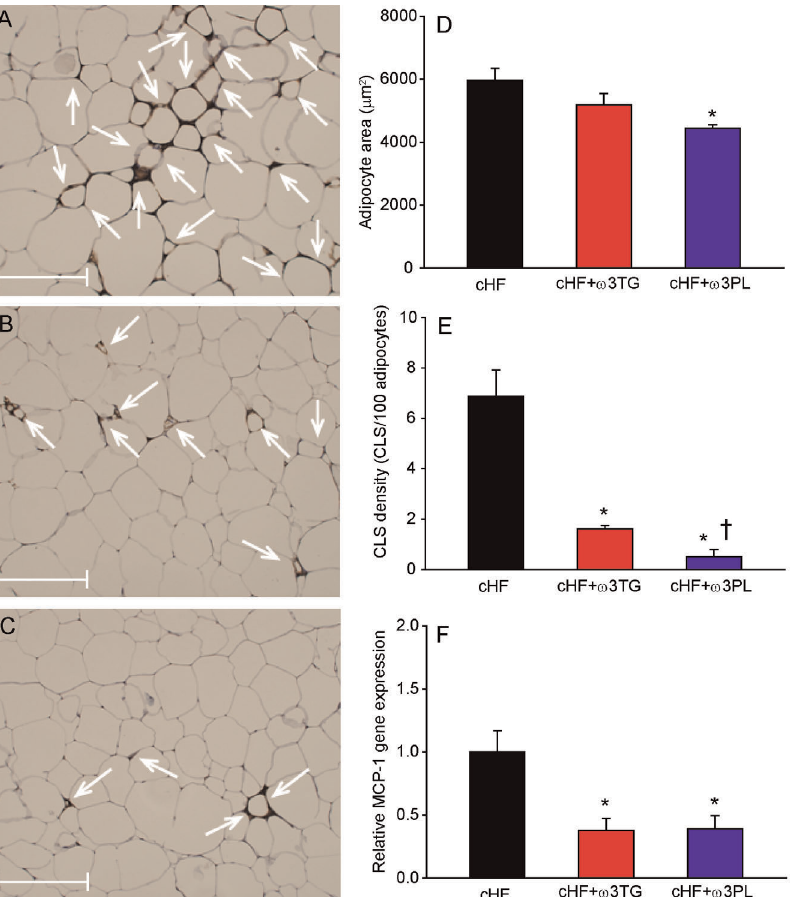
Figure 5. Reversal of adipose tissue hypertrophy and low-grade inflammation by dietary LC n -3 PUFA. Following a 4-month period of cHF-feeding, mice were fed for additional 9 weeks with cHF diet or treated using either cHF + v 3TG or cHF + v 3PL diet supplemented with 30 g DHA/ EPA per kg; all diets also contained 2 g metformin per kg. Hematoxyline-eosin staining of epididymal fat sections from mice fed cHF ( A ), cHF + v 3TG ( B ), or cHF + v 3PL ( C ) diet. D Adipocyte size; morphometric analysis was based on more than 1,000 cells taken randomly from 5 different areas per animal ( n =3). E Amount of MAC-2 immunoreactive macrophages in the above tissue sections, expressed as the number of crown-like structures ( CLS ; indicated by white arrows in A–C ). F Adipose tissue gene expression of monocyte chemoattractant protein-1 ( MCP-1 ), a chemokine which is involved in the recruitment of monocytes to sites of injury and infection. cHF diet, black bars; cHF + v 3TG diet, red bars; cHF + v 3PL diet; blue bars. A-C , Scale bars=200 m m. Data are means 6 SEM (n=7 2 8; D–F ). *Significantly different from cHF; { significantly different from cHF + v 3TG (all analyses by ANOVA).